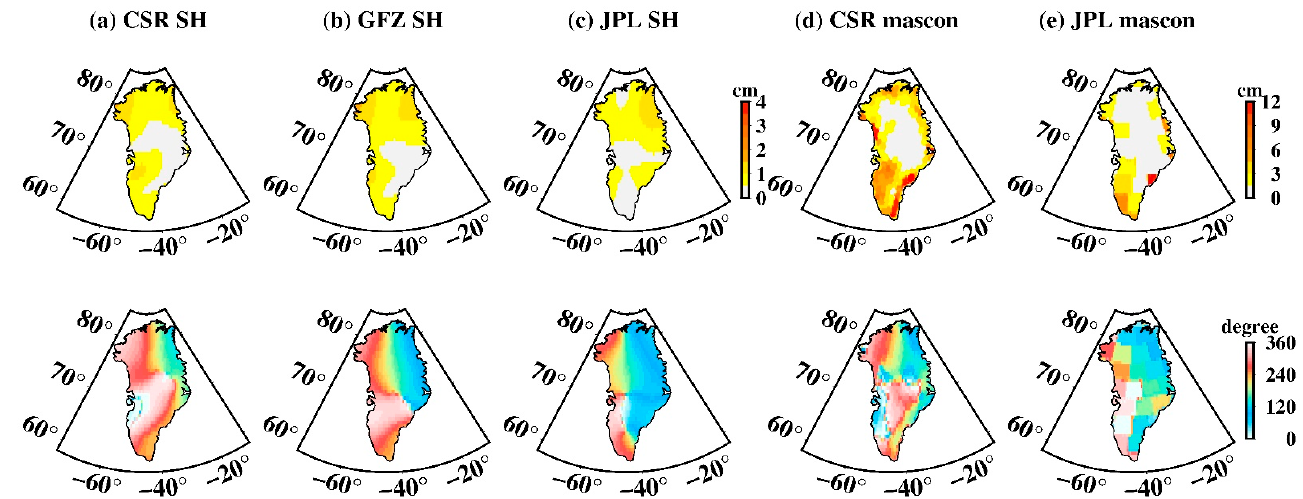
Figure 9. Spatial amplitude and the corresponding phase maps of S 2 tide aliasing over